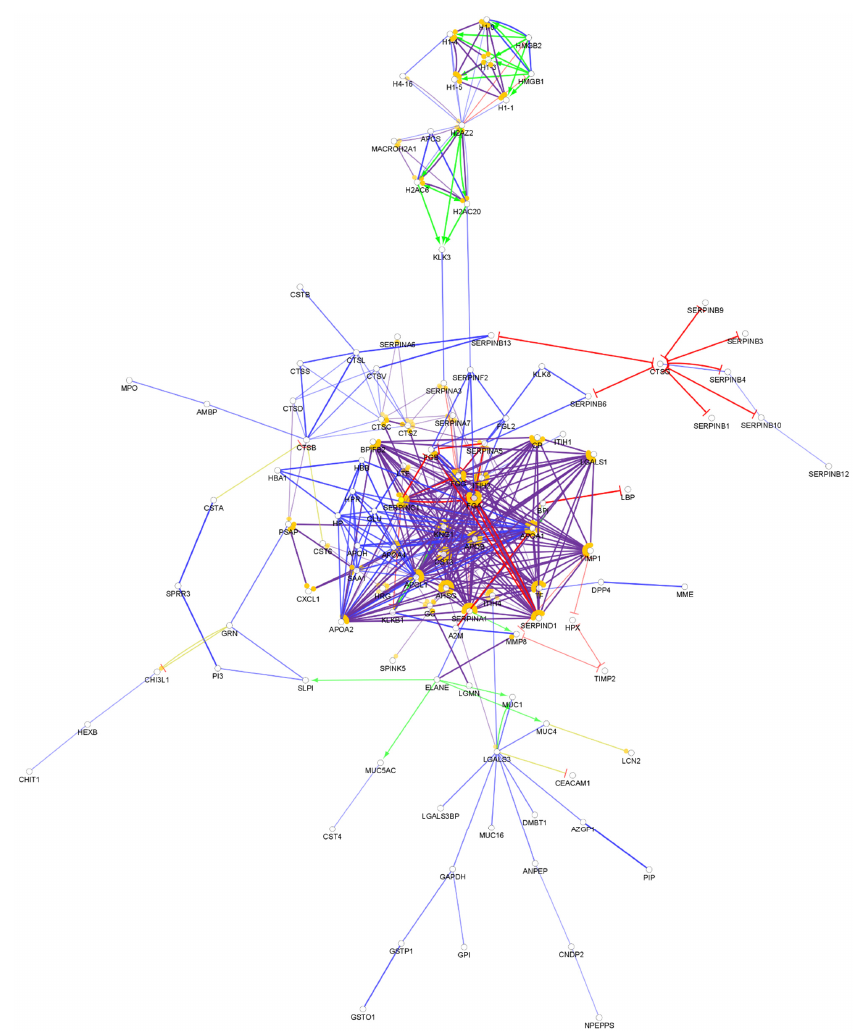
Figure 7. Partial network view of the interaction network of the chemical barrier proteins in cervicovaginal fluid. Each circle represents a protein and the lines indicate interactions. The lines with an arrow represent activation, blocking lines represent inhibition, and simple lines represent protein–protein interaction. Line color indicates the type of interaction: green color refers to activation, red color to inhibition, blue color to binding, yellow color to co-expression, and purple color to catalysis. The proteins are labeled with their gene name. The high resolution and complete network image of this network is presented in Figure S7.